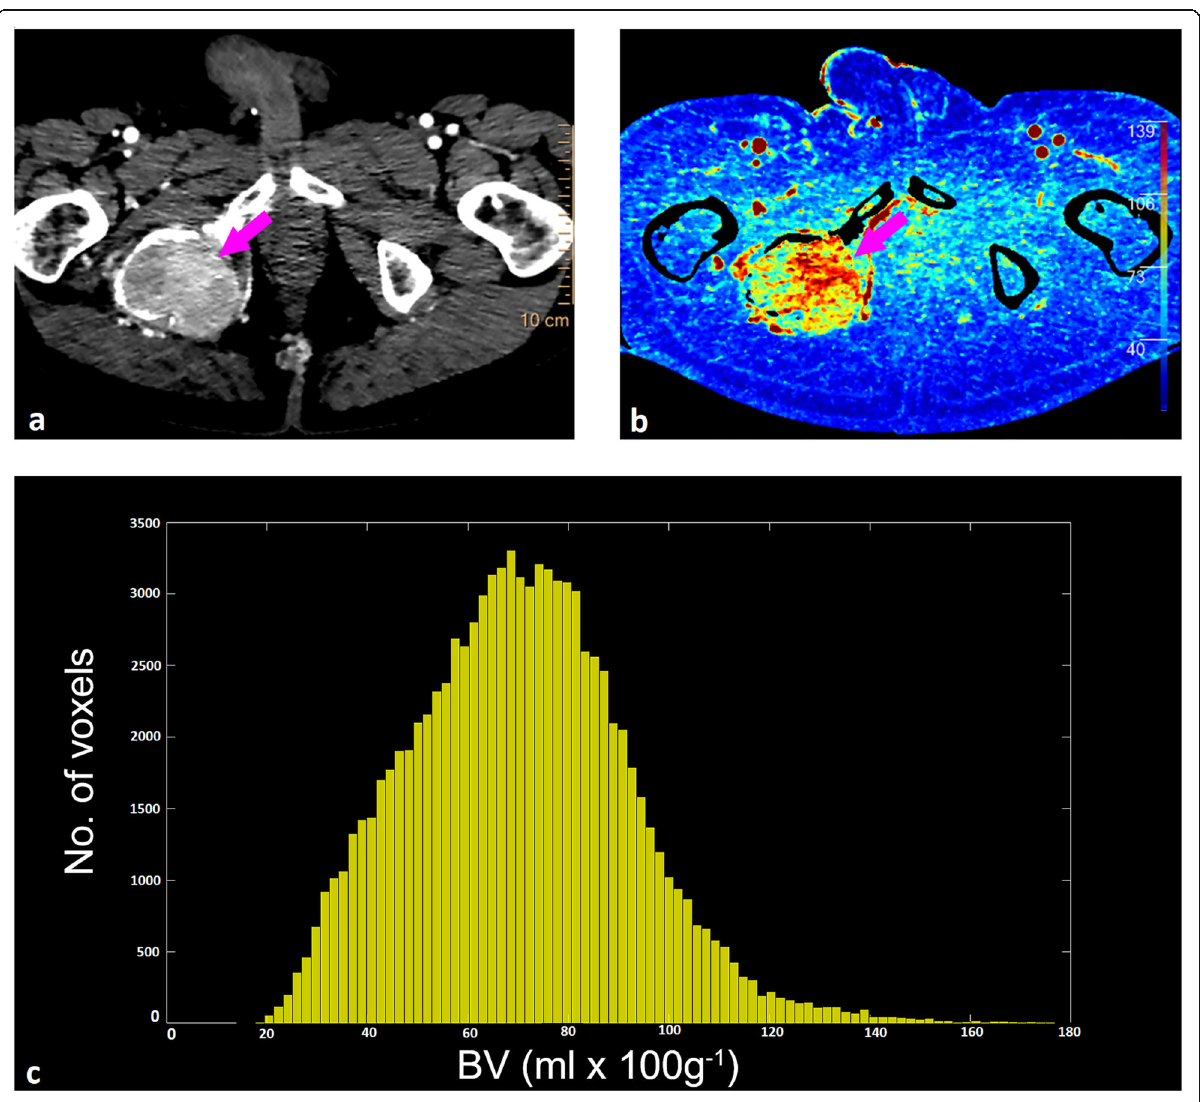
Fig. 1 A heterogeneous metastasis in the right iliac bone (purple arrow) at baseline presented on (a) CE-CT, (b) BV deconv map, and (c) the corresponding BV deconv histogram. The histogram depicts a large BV range, illustrating the intratumoural heterogeneity. BV deconv Blood volume (deconvolution), CE-CT Contrast-enhanced computed tomography, No.